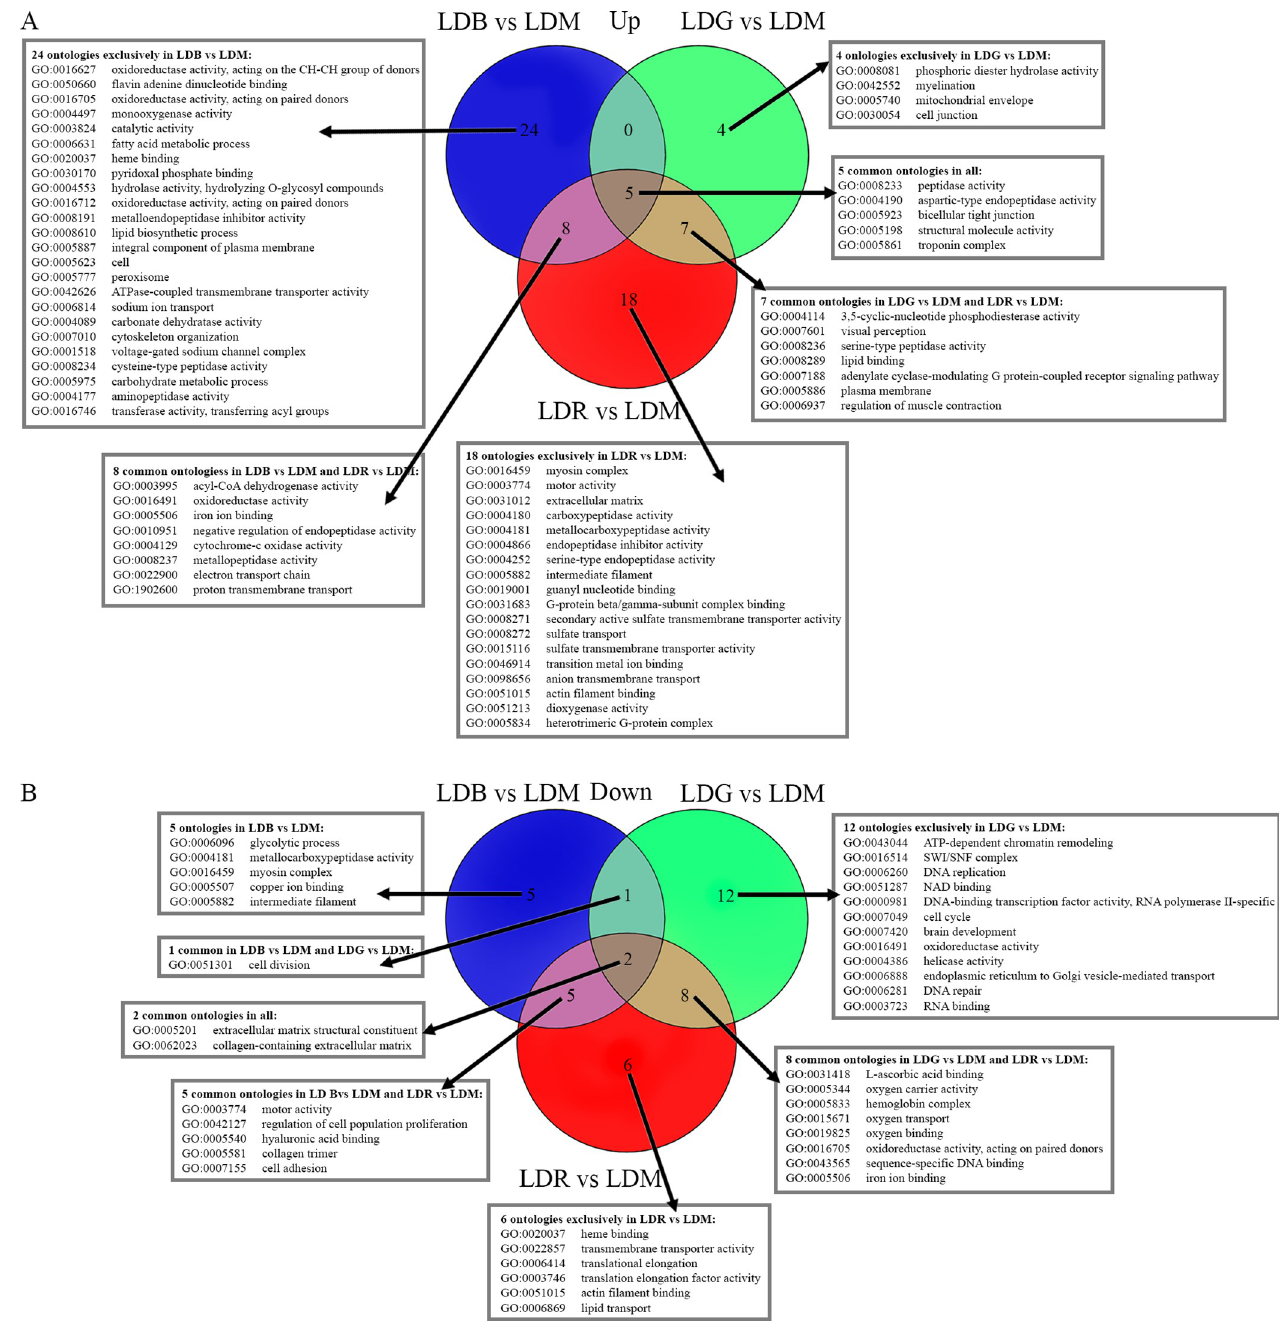
Fig 6. Venn diagrams of Gene Ontologies (GO) comparing wavelengths used during the light phase of the LD cycle. A) Upregulated GO terms when comparing blue, green and red light to white light (LDM), where five ontologies were common in all lighting conditions. B) Downregulated GO terms comparing blue, green or red light to white light (LDM), where two ontologies were found to be common despite the use of different